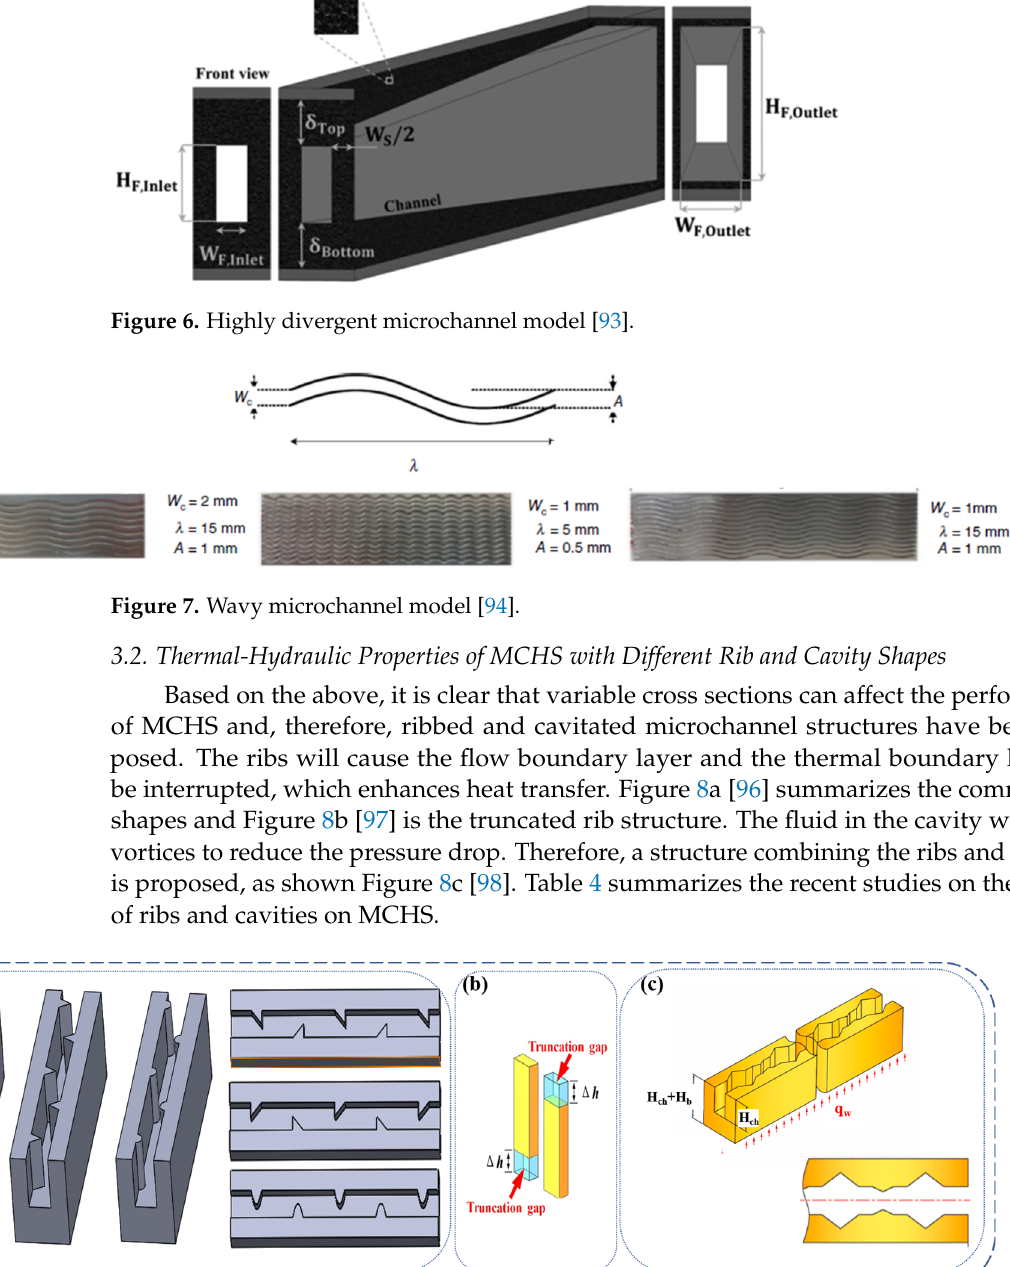
Figure 8. Models of different shapes of ribs and cavities: ( a ) shape of ribs [96]; ( b ) shape of truncated ribs [97]; ( c ) structure of ribs and cavities [98]. Table 4. Effect of ribs and cavities on the performance of MCHS.